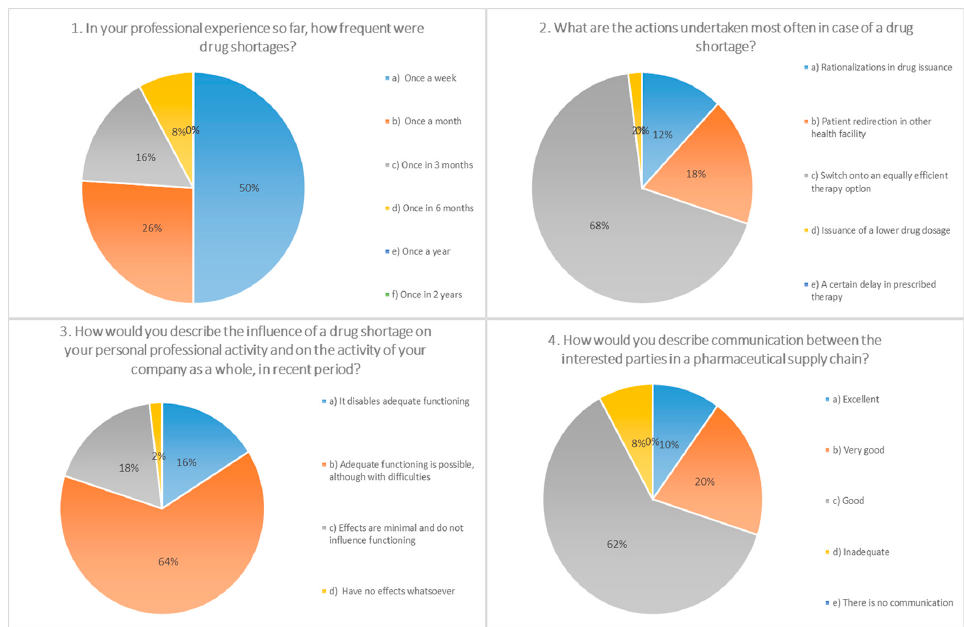
Figure 1. Questions 1 to 4 from a 15-question survey, distributed electronically to community pharmacies in 23 cities in Serbia on behalf of the Faculty of Pharmacy, Novi Sad. The survey was available for completion between February and April, 2019. The survey was anonymous, as contact information was not requested. Data collected from the survey included demographic information. The majority of the questions were multiple choice, allowing respondents to select a pre-specified answer. A total of 500 surveys were administered to community pharmacies.